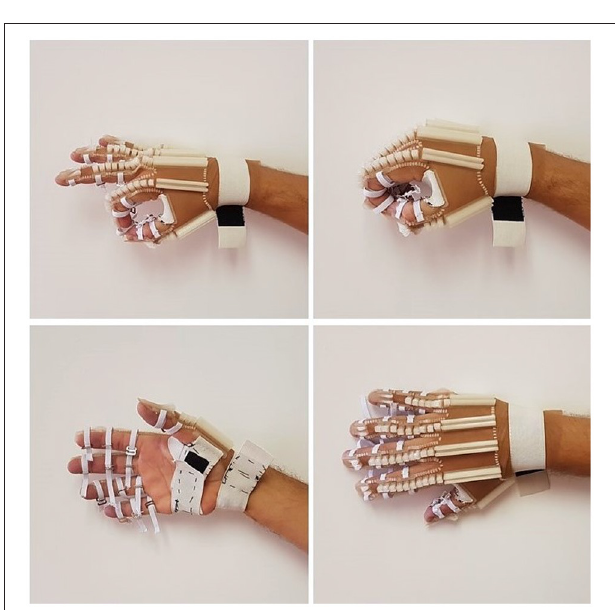
FIGURE 4 | Final prototype of the exoskeleton’s glove.